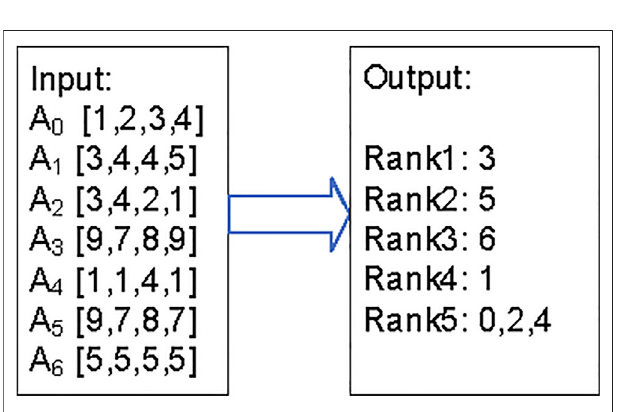
FIGURE 7 | a simple example to illustrate the multi-indicators evaluation